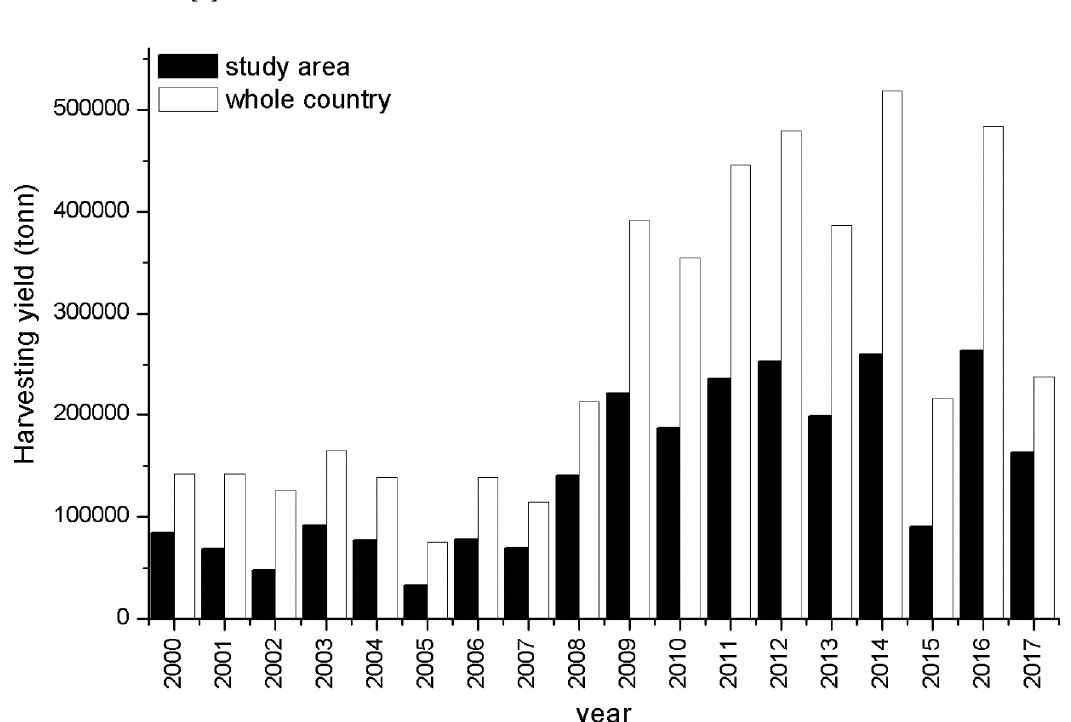
Figure 1. Whole Mongolian grain production with study area (National Statistics Office, 2019).